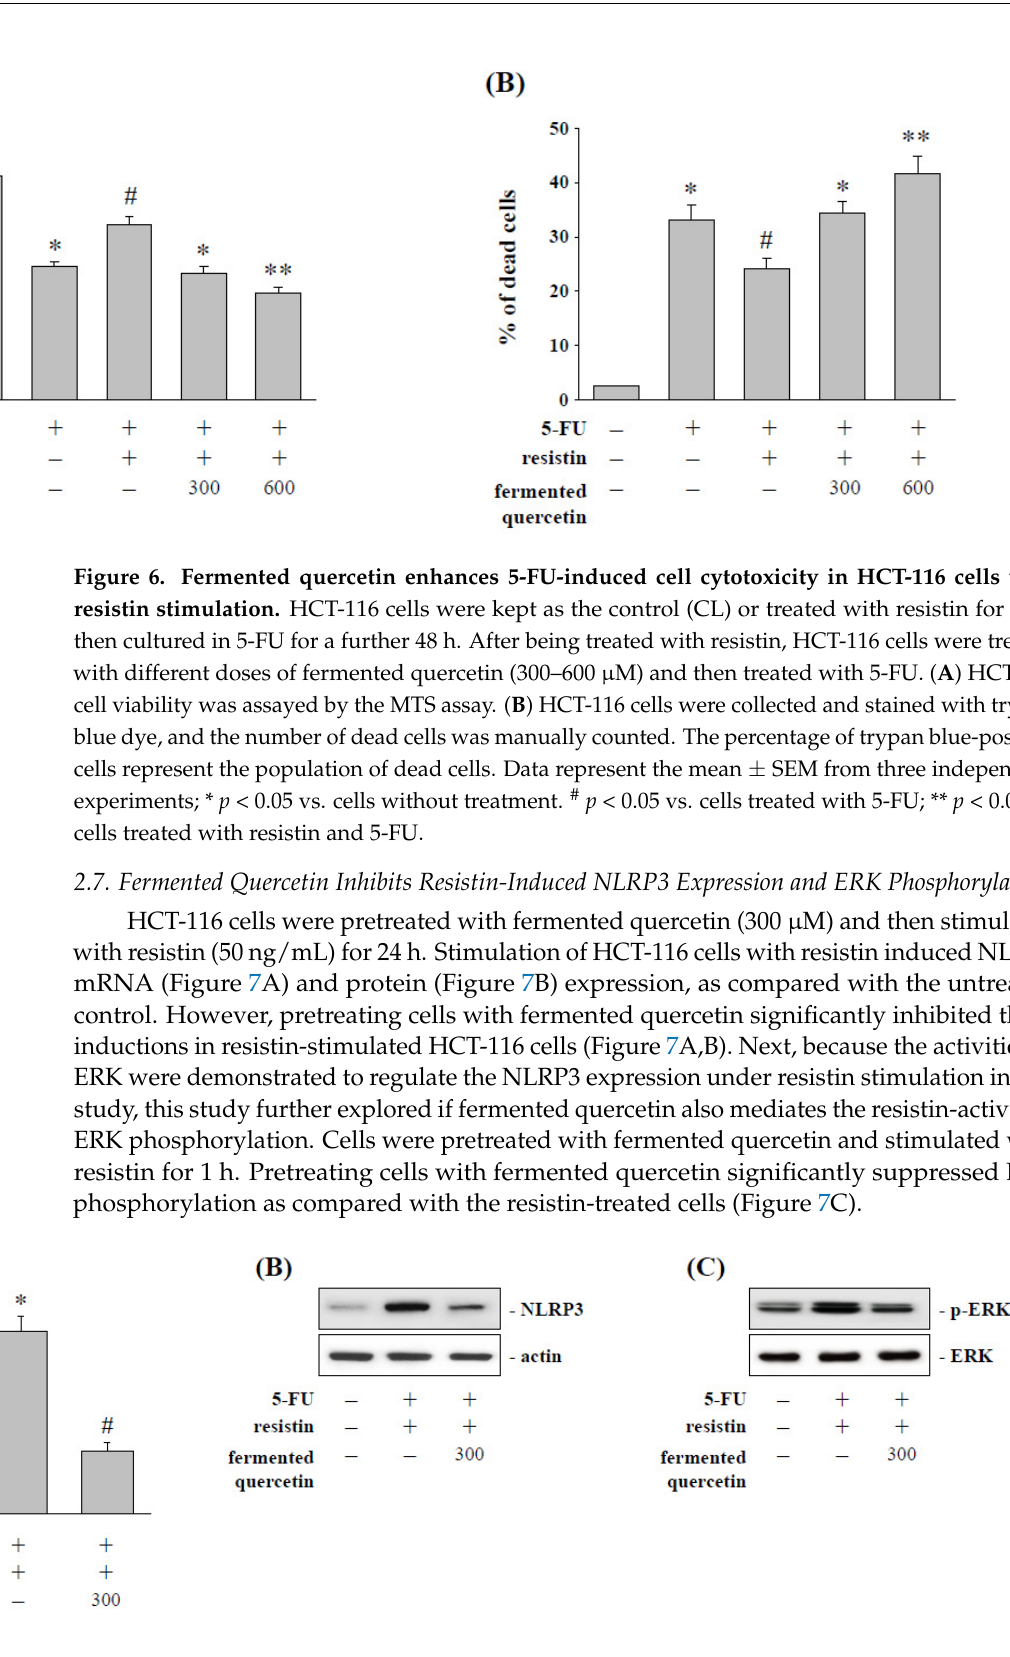
Figure 7. Fermented quercetin regulates NLRP3 expression and ERK phosphorylation of resistin- treated HCT-116 cells. HCT-116 cells were kept as the control (CL) or treated with resistin for 12 h, then cultured in 5-FU for a further 48h. After being treated with resistin, HCT-116 cells were treated with fermented quercetin and then treated with 5-FU. The mRNA ( A ) and protein ( B ) expression of NLRP3 were determined by real-time PCR and Western blotting, respectively. ( C ) The ERK phos- phorylation was determined by Western blotting. Data in ( A ) are shown as mean ± SEM from three independent experiments. * p < 0.05 versus CL. # p < 0.05 versus DMSO/5-FU-treated cells. Results in ( B , C ) are representative of three independent experiments with similar results.